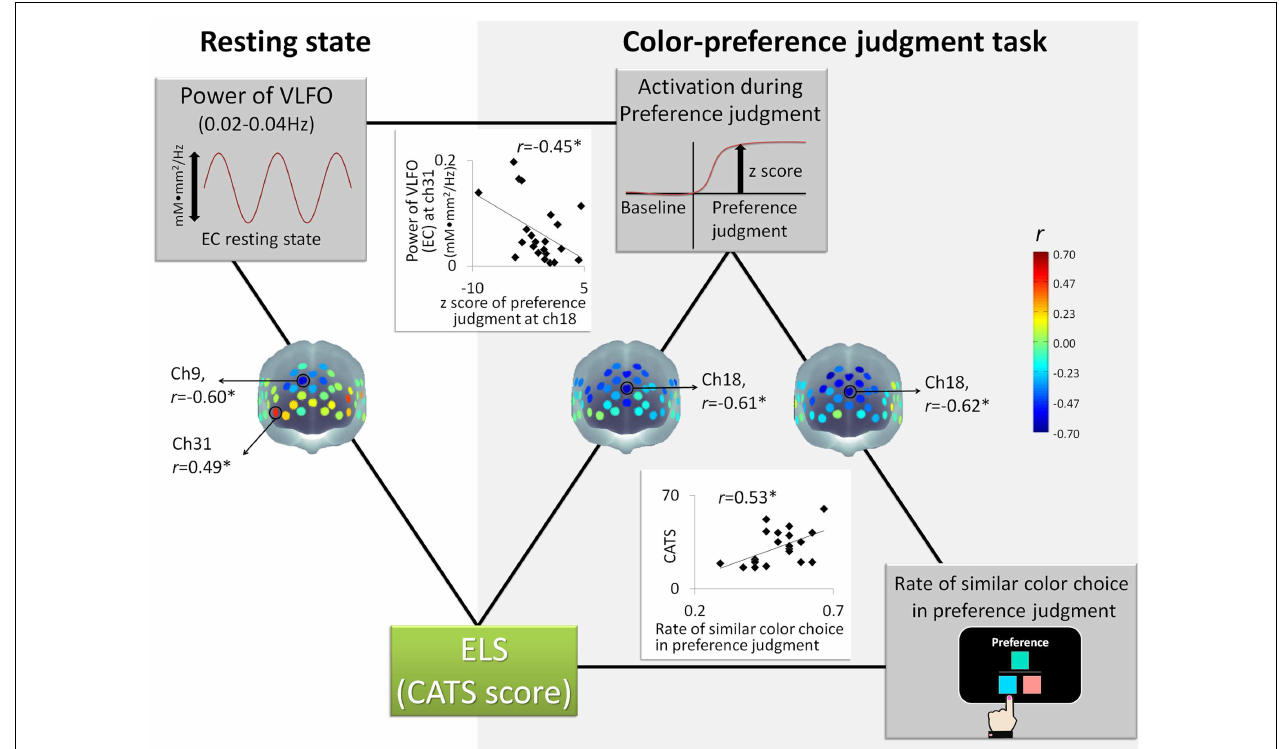
FIGURE 2 | Schematic figure of each measurement and correlation results: *represents statistically significant r value ( p < 0.05); ELS stands for early life stress; CATS denotes the ChildAbuse andTrauma Scale; EC denotes eyes closed;VLFO denotes very low-frequency oscillations .